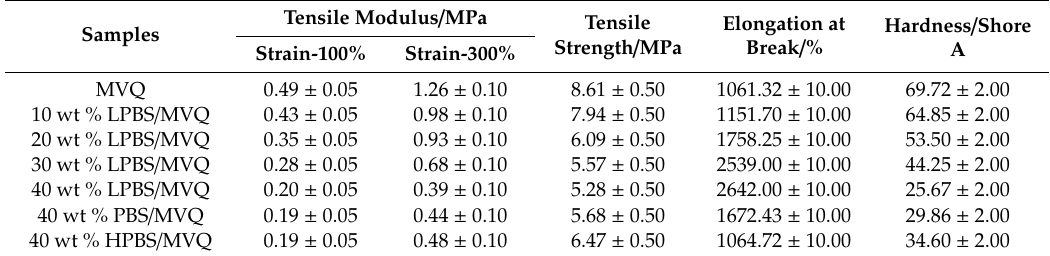
Table 2. Tensile properties of MVQ and MVQ / STG composite